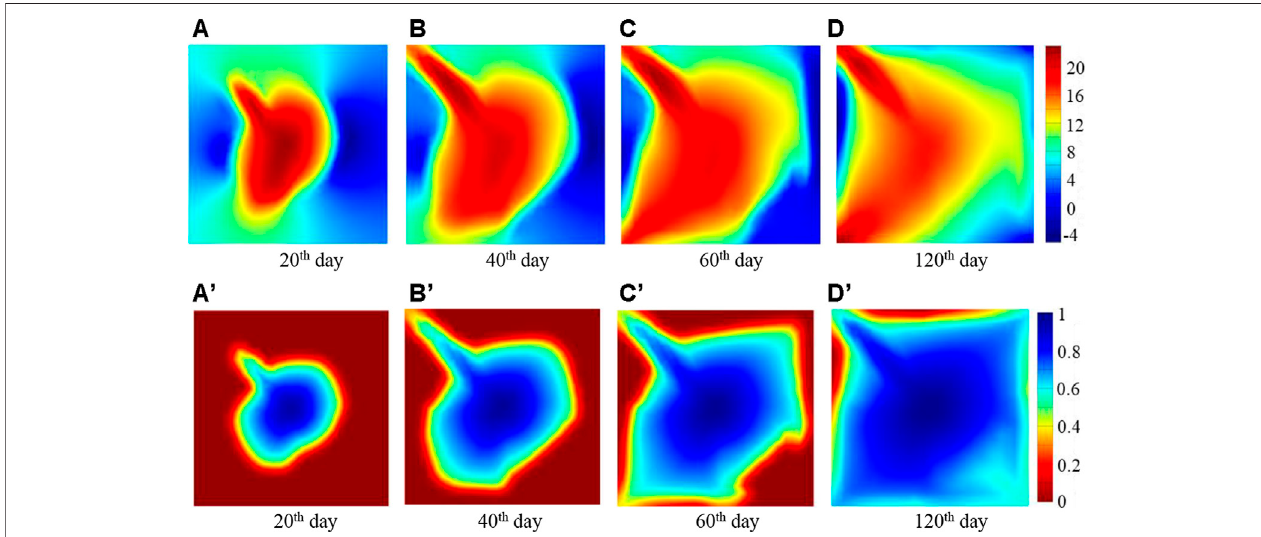
FIGURE 7| The magnetic anomaly and ferro fl uid saturation distribution at different time. (A – D) respectively show themagnetic anomaly at 20th, 40th, 60th, 120th day; (A 9 – D 9 ) respectively show the ferro fl uid saturation at 20th, 40th, 60th, 120th day.